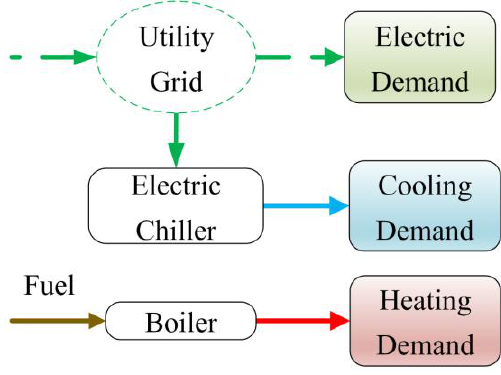
Figure 1. Schematic of the reference system (separate heat and power generation) [11,20].